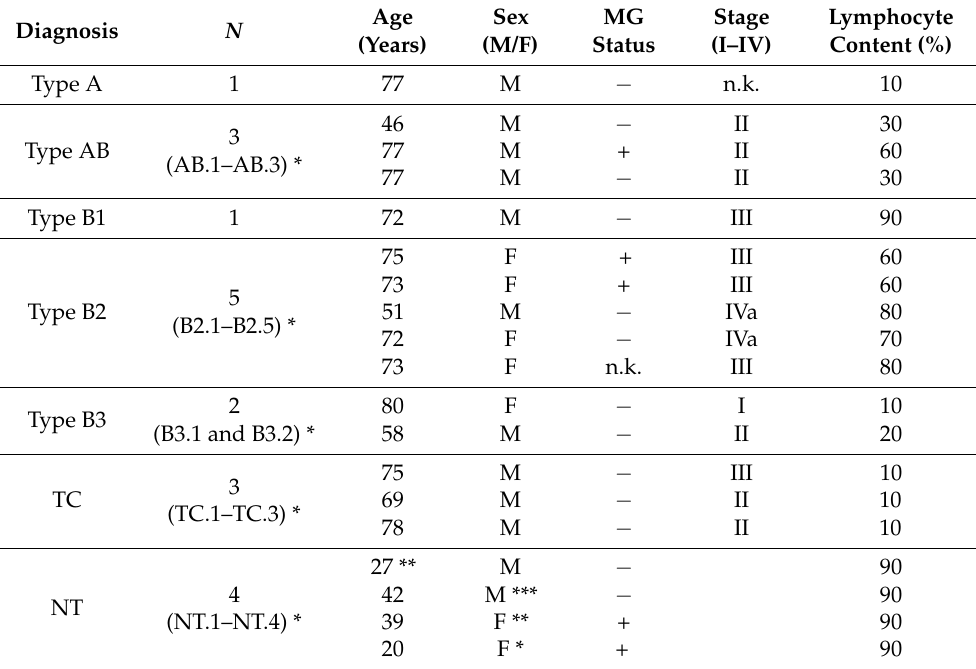
Table 1. Clinico-pathological characteristics of the 12 thymoma patients and 3 thymic carcinoma (TC) patients, as well as 4 controls (non-neoplastic thymi, NT) studied here. Diagnosis: the histological classification of thymomas (types A, AB, B1, B2, and B3) and TCs followed the World Health Organization (WHO) [1]. Stage (I–IV): local tumor extension (I–III) and pleural spread (IVa) are given according to the Masaoka-Koga classification [15]. Lymphocyte contents of tumor samples